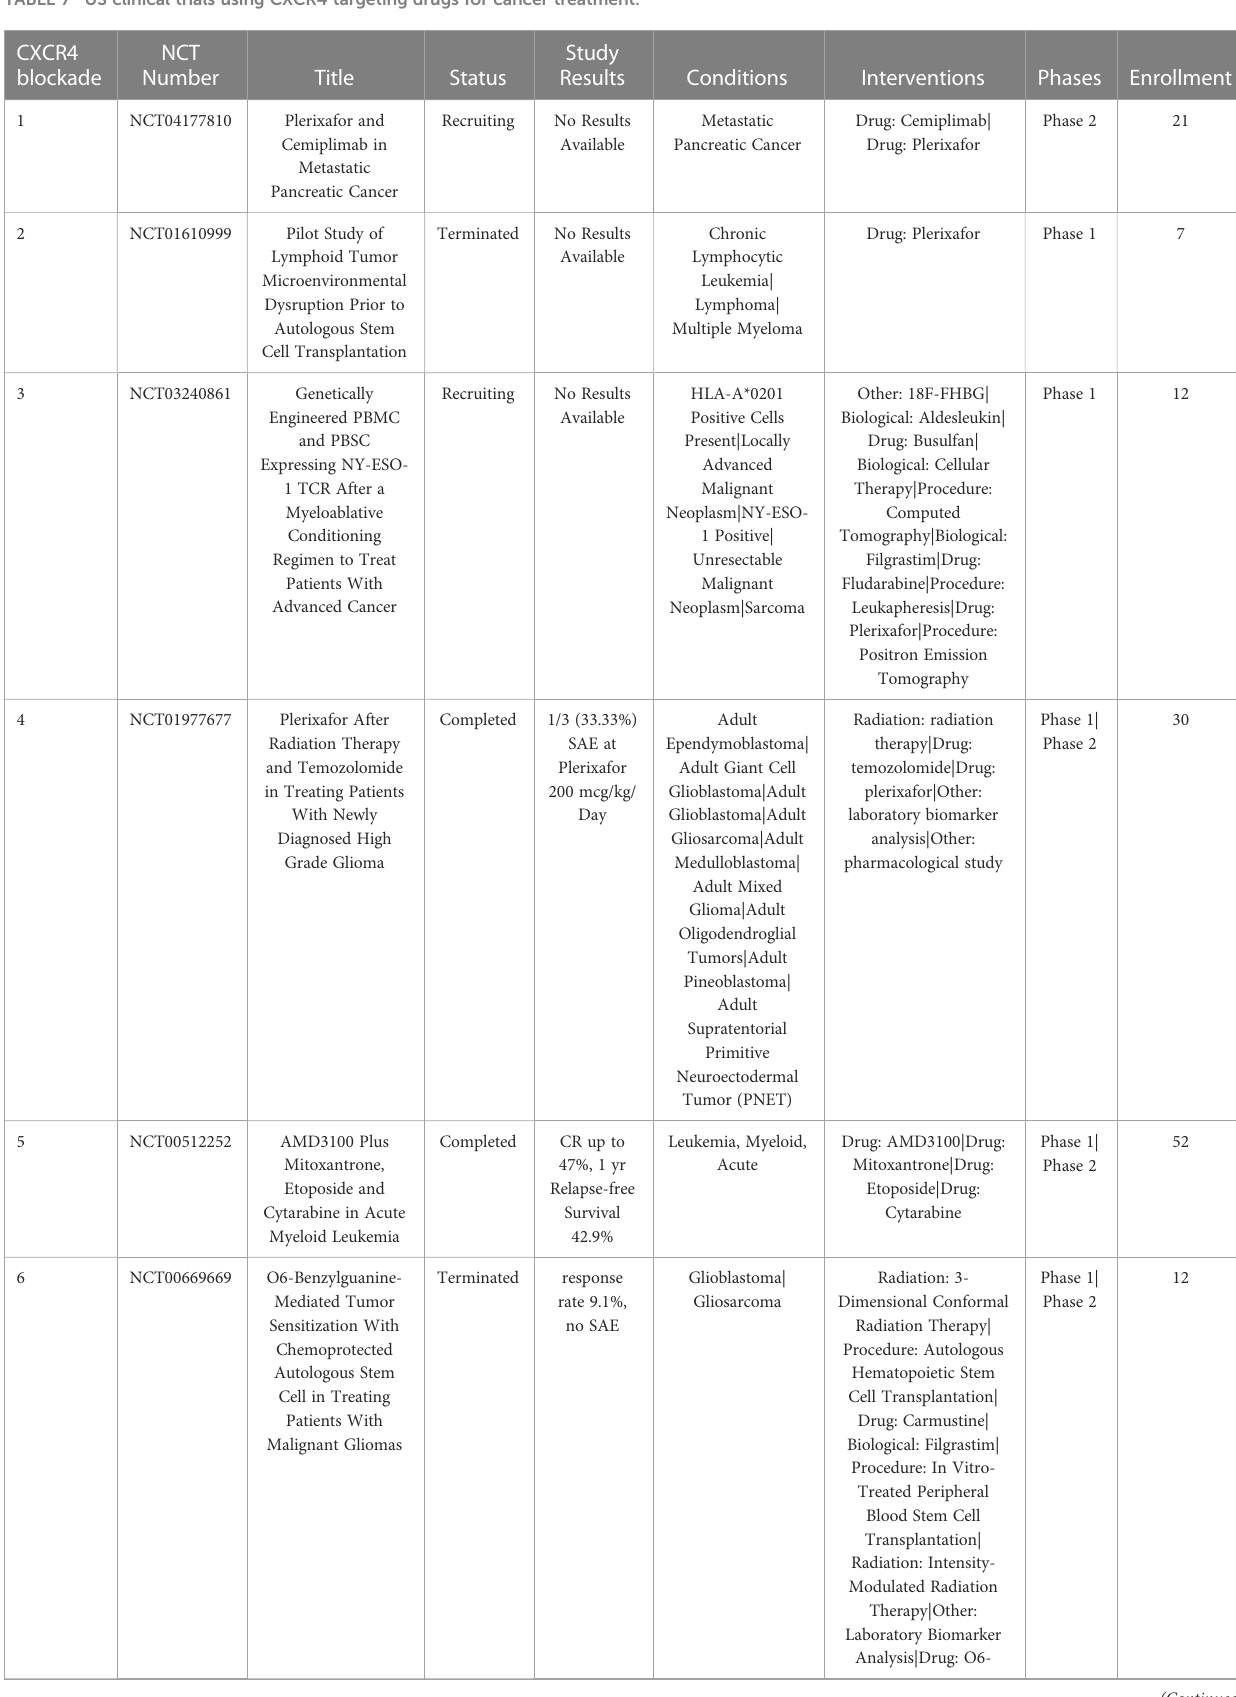
TABLE 7 US clinical trials using CXCR4 targeting drugs for cancer treatment. CXCR4